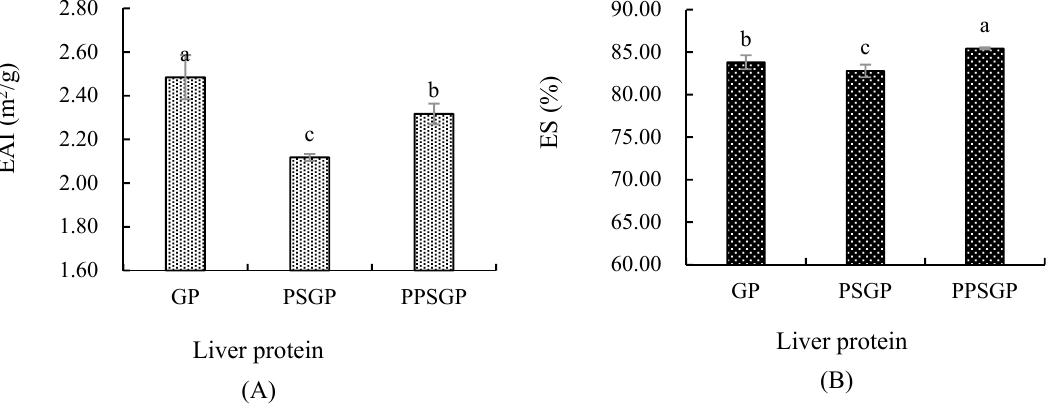
Figure 5. Emulsifying activity and emulsion stability of goose liver protein isolate. ( A ) EAI, emulsify- ing activity index; ( B ) ES, emulsion stability. Different letters indicate significant differences.